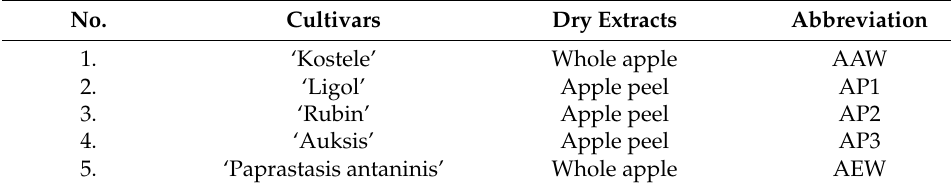
Table 1. The study used apple samples and their